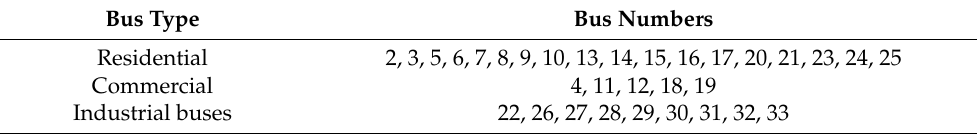
Table 1. Grouping of buses data,